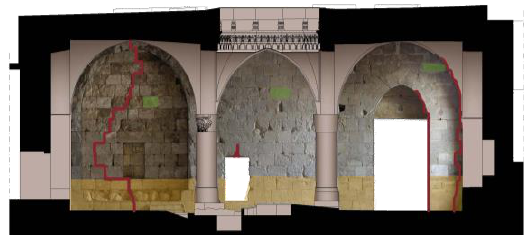
Figure 15. The crack pattern surveyed on the north internal wall of the Ayyubidd Hall